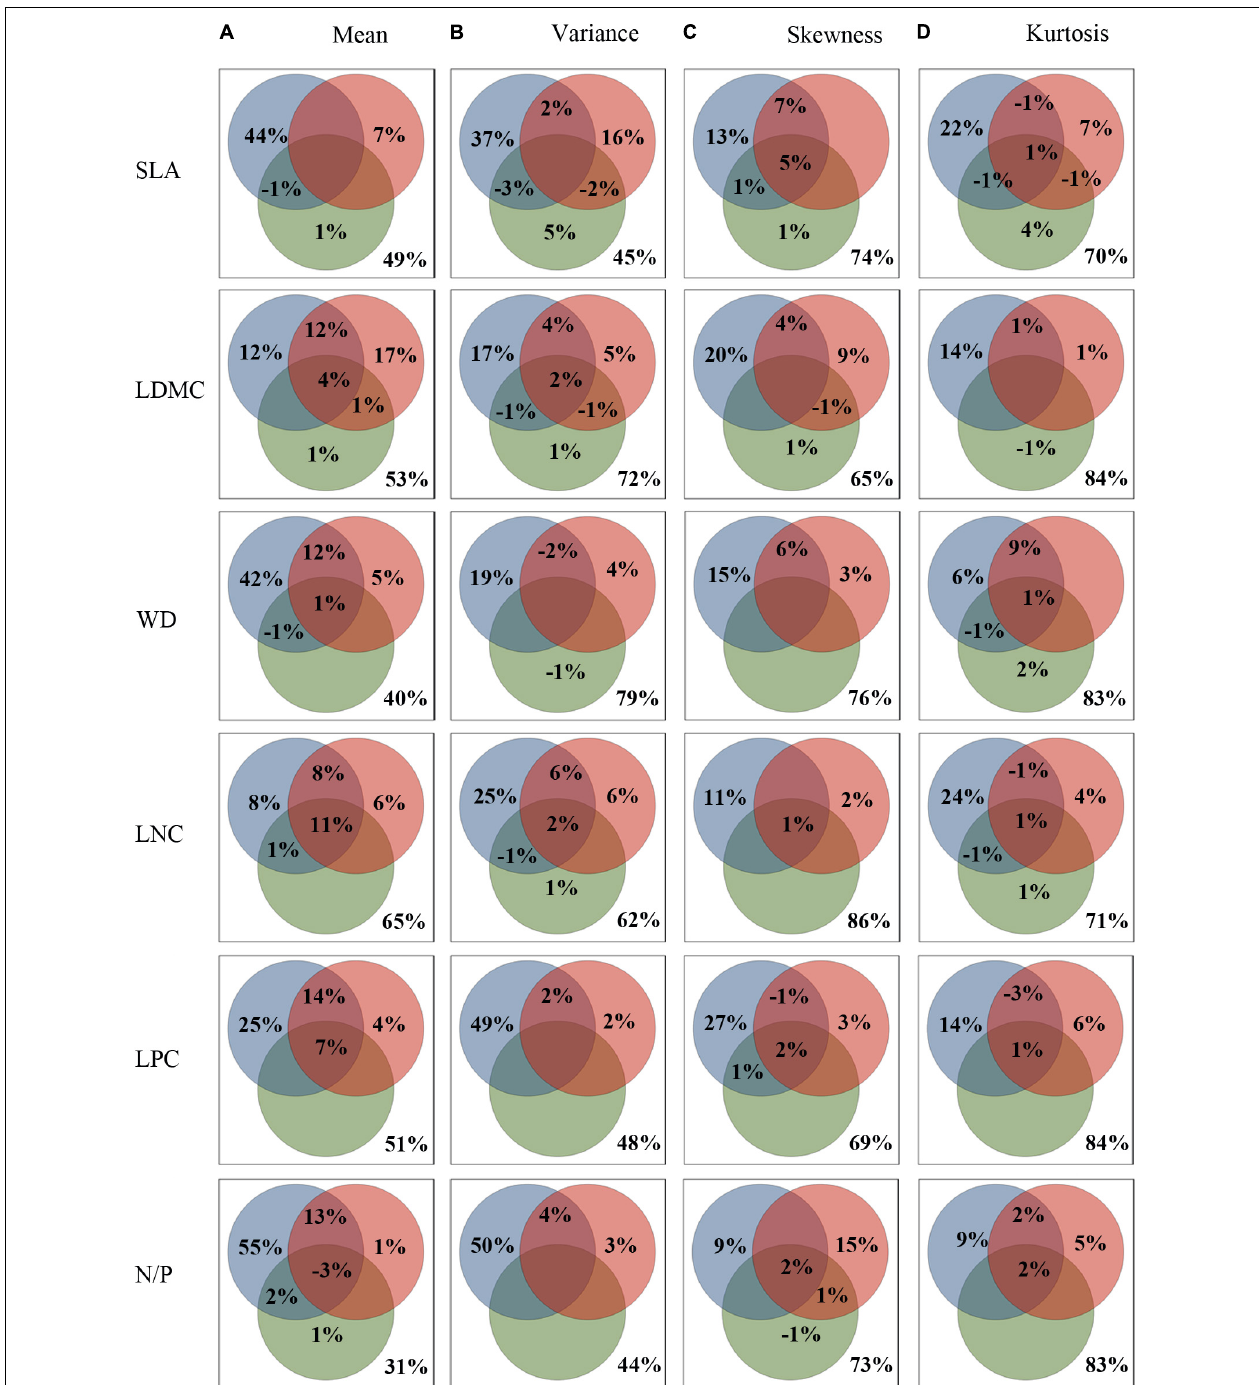
FIGURE 3 | Variance partitioning of community-weighted trait moments across all functional traits explained by environment. (A–D) showing the variance partitioning of climatic (blue), edaphic (red), and topography (green) variables in accounting for the variance in community-weighted trait moments. Functional traits are abbreviated as follows: leaf dry matter content (LDMC), leaf nitrogen concentration (LNC), leaf phosphorus concentration (LPC), leaf nitrogen/phosphorus ratio (N/P), specific leaf area (SLA), wood density